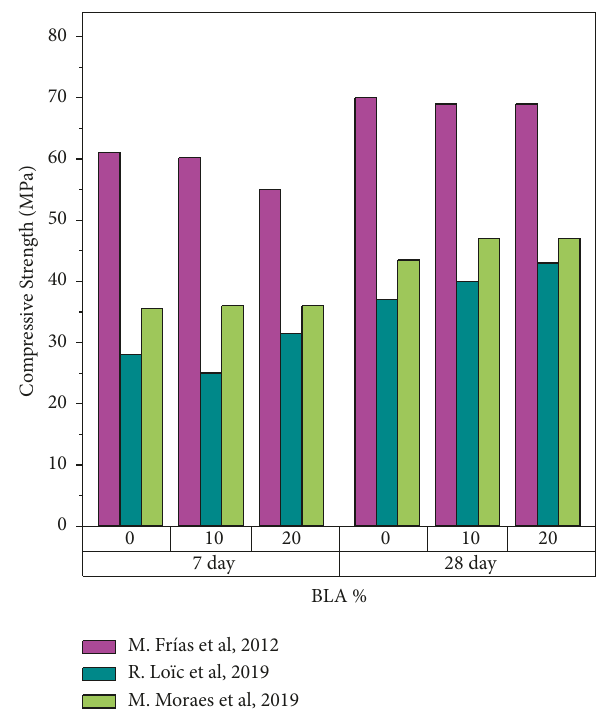
Figure 17: Compressive strength of binary mortars at 7 and 28